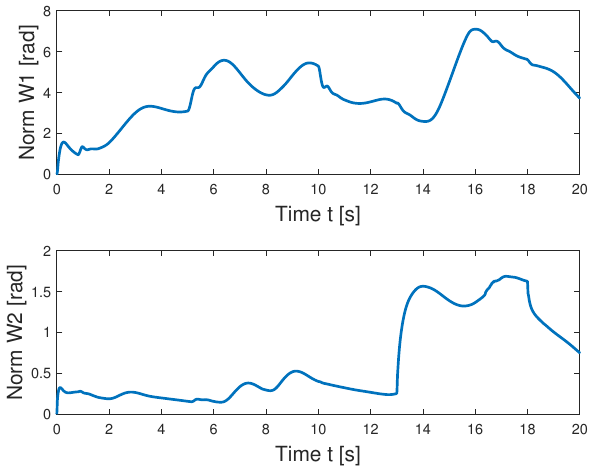
Figure 12. Norms of the adaptation weights W (NNs-based control).